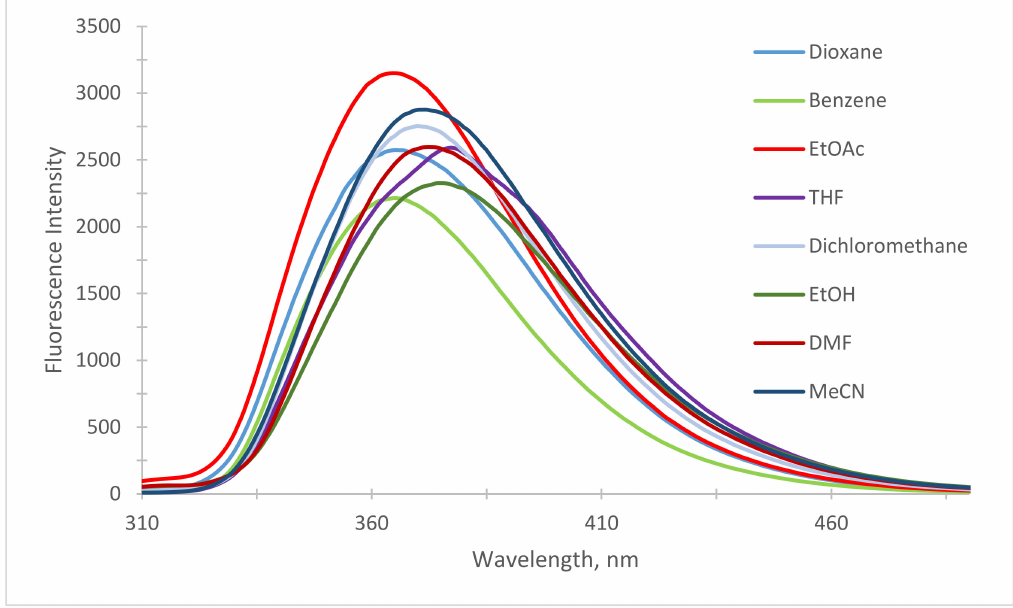
Figure 9. Fluorescence spectra of 4l in di ff erent solvents at room